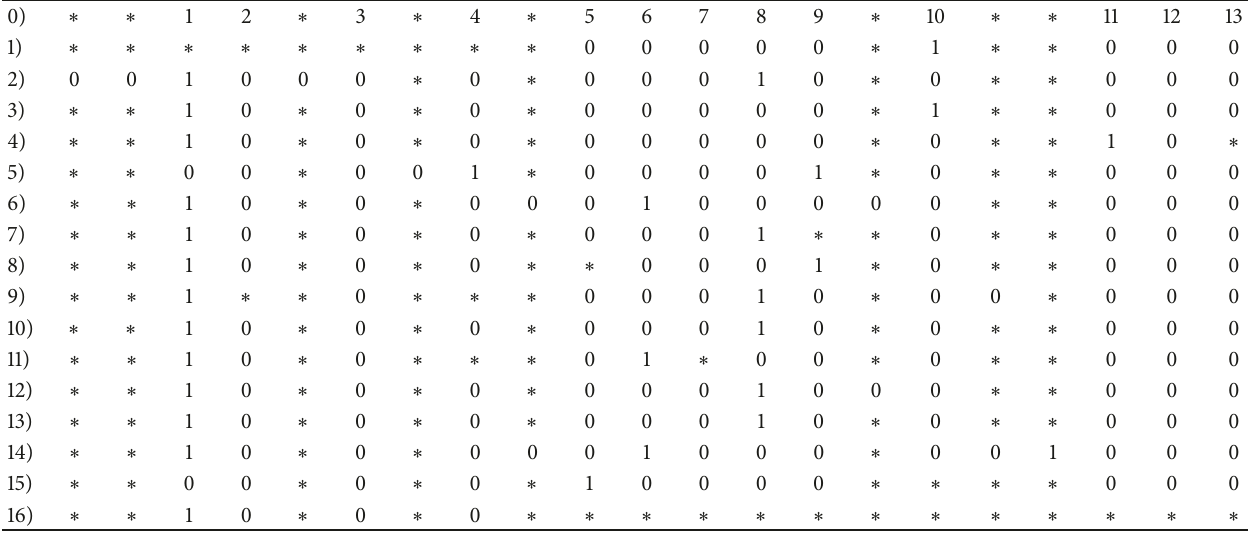
Table 3: Multiple alignment with the replacement of letters by 0 and 1 for the work of Robert Frost “Fire and Ice.” The null line shows the positions of the